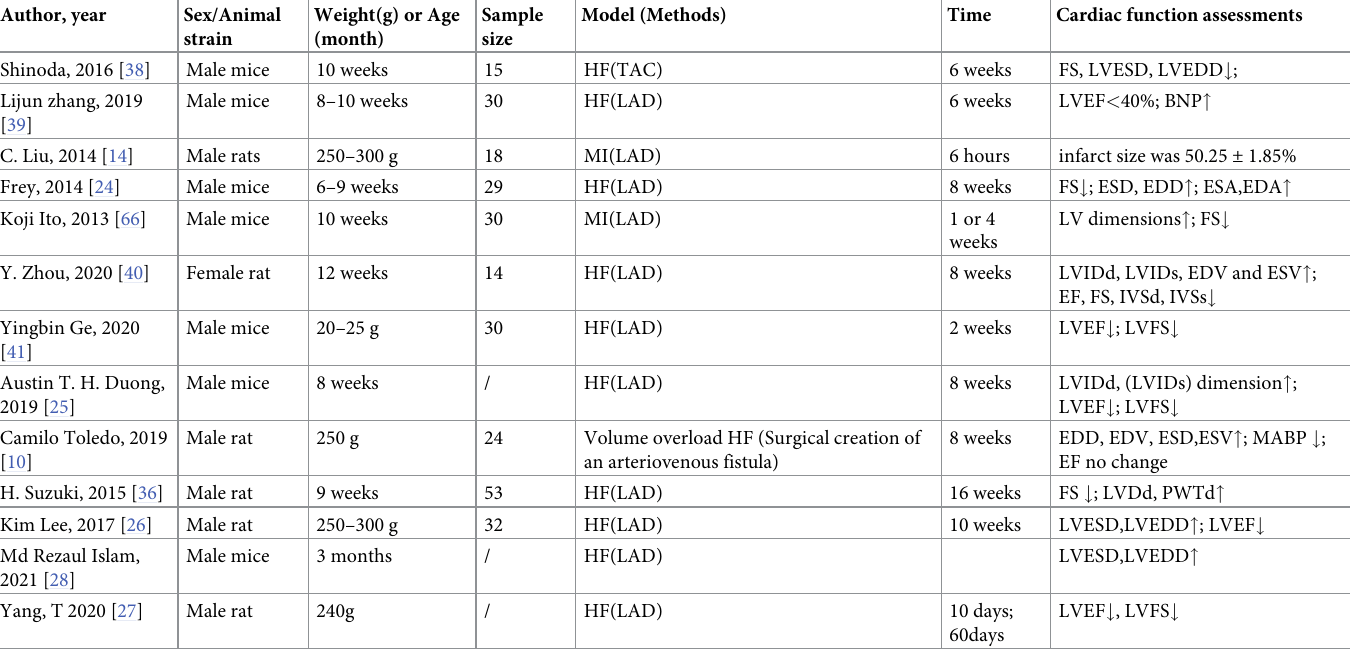
Table 2. General characteristics information and cardiac function of experimental studies.